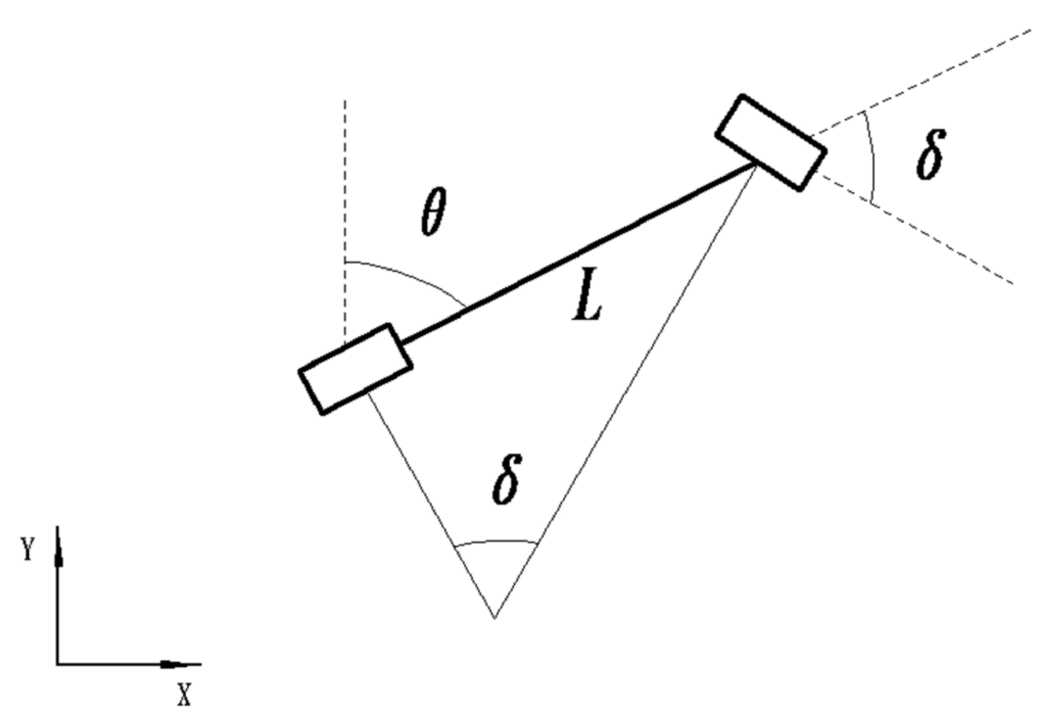
Figure 1. Vehicle kinematics